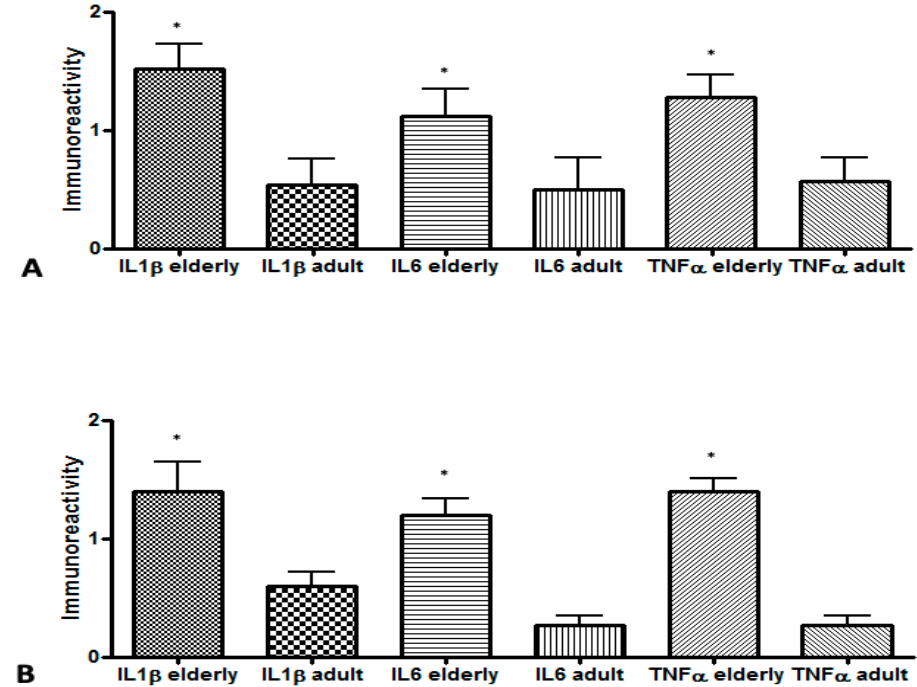
Figure 3. Comparison of pro-inflammatory cytokines in chronic apical periodontitis lesions between elderly and young/middle-aged patients: ( A ) cyst (IL-1 β elderly–IL-1 β adult, p = 0.008; IL-6 elderly–IL-6 adults, p = 0.016; TNF- α elderly–TNF- α adult; p = 0.008); ( B ) granuloma (IL-1 β elderly–IL-1 β adult, p = 0.041; IL-6 elderly–IL-6 adults, p = 0.002; TNF- α elderly–TNF- α adult; p = 0.002). Mann– Whitney test (* significant difference).